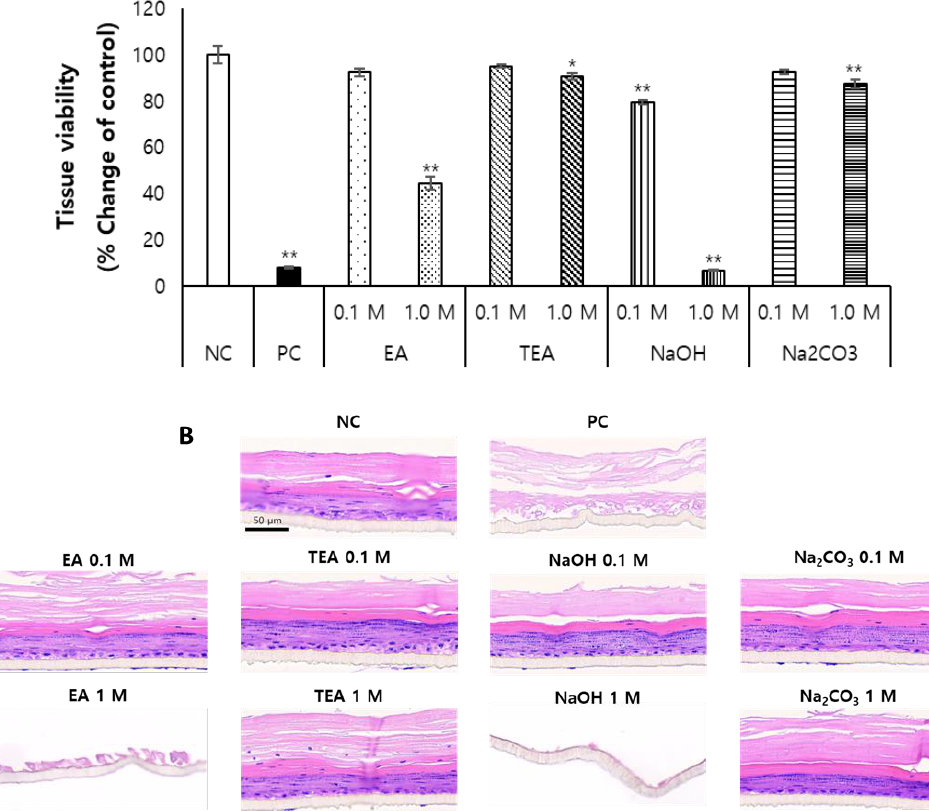
Figure 4. Various organic and inorganic alkalis were prepared at a low concentration (0.1 M) and a high concentration (1.0 M) and exposed to KeraSkin™ for 30 min. Then, ( A ) cell viability was evaluated, and ( B ) skin tissues were stained with H&E. Scale bar is 50 μm. NC; negative control (DW) with white bars, PC; positive control (5% SDS) with filled bars. Tested samples with patterned bars, EA; ethanolamine, TEA; triethanolamine, NaOH; sodium hydroxide, Na 2 CO 3 ; sodium carbonate. * p < 0.05, ** p <